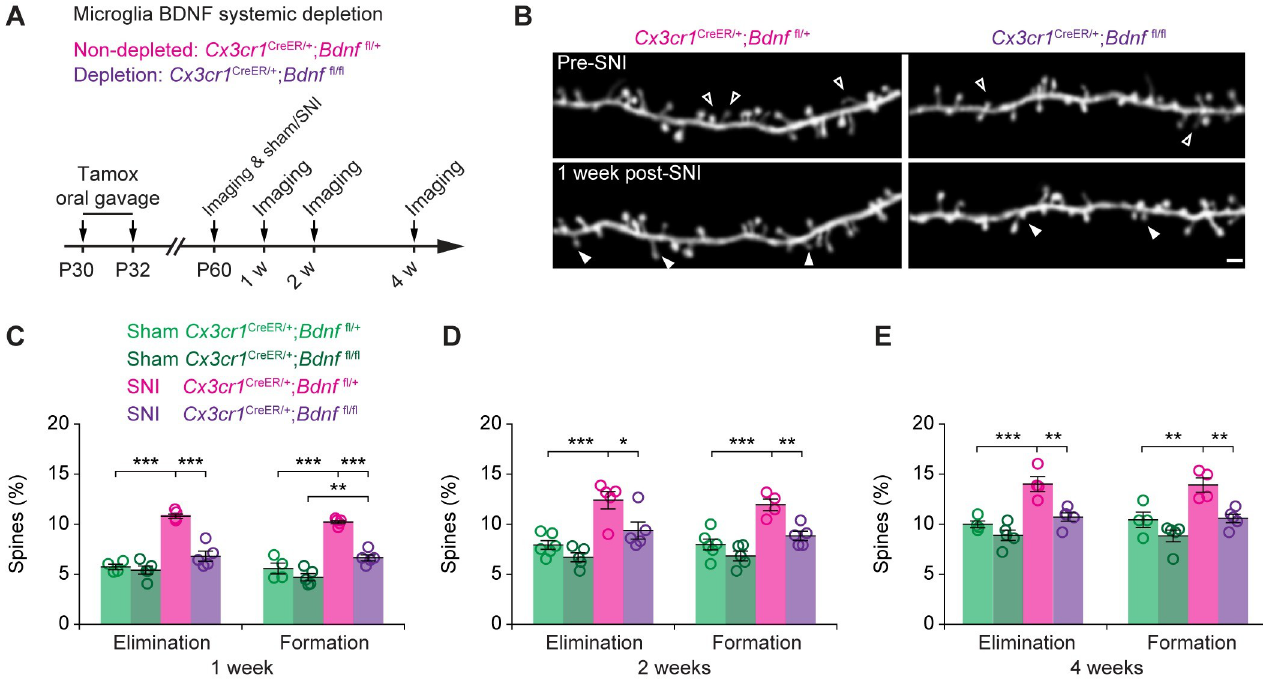
Fig 4. Systemic depletion of microglial BDNF reduces dendritic spine remodeling in the S1 after peripheral nerve injury. ( A ) Experimental timeline. ( B ) Representative two-photon images of dendritic segments in SNI mice with ( Cx3cr1 CreER/+ ; Bdnf fl/+ ) or without microglial BDNF ( Cx3cr1 CreER/+ ; Bdnf fl/fl ). Empty and filled arrow heads indicate individual spines that were eliminated or newly formed, respectively, 1 week after SNI. Scale bar, 2 μ m. ( C – E )Percentages of dendritic spines eliminated and formed 1 week ( C ), 2 weeks ( D ), or 4 weeks ( E ) after sham or SNI surgery. Sham Bdnf f/+ : n = 4–6 mice; SNI Bdnf fl/+ , n = 4–5 mice; sham Bdnf fl/fl , n = 5 mice; SNI Bdnf fl/fl , n = 5 mice. Throughout, individual circles represent data from a single mouse. Summary data are presented as mean ± SEM. � P < 0.05, �� P < 0.01, ��� P < 0.001; by one-way ANOVA followed by Tukey multiple comparisons test ( C–E ). The data underlying this figure can be found in S1 Data. BDNF, brain-derived neurotrophic factor; SNI, spared sciatic nerve injury; S1, primary somatosensory cortex.